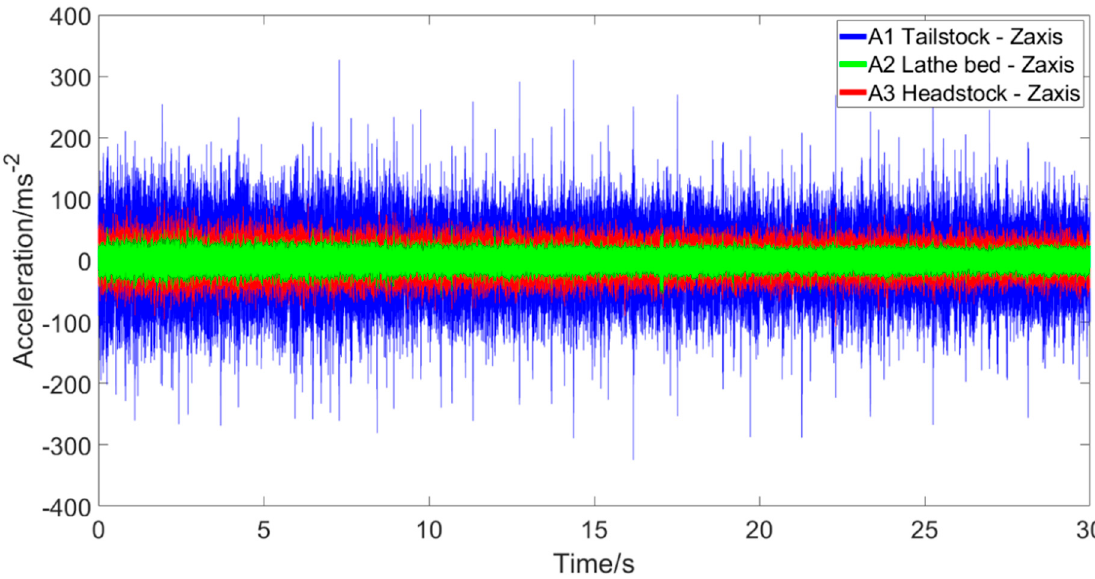
Figure 12. Example measured vibration dataset, collected while performing a 2 mm depth of cut on a CNC lathe using a new cutting tip.